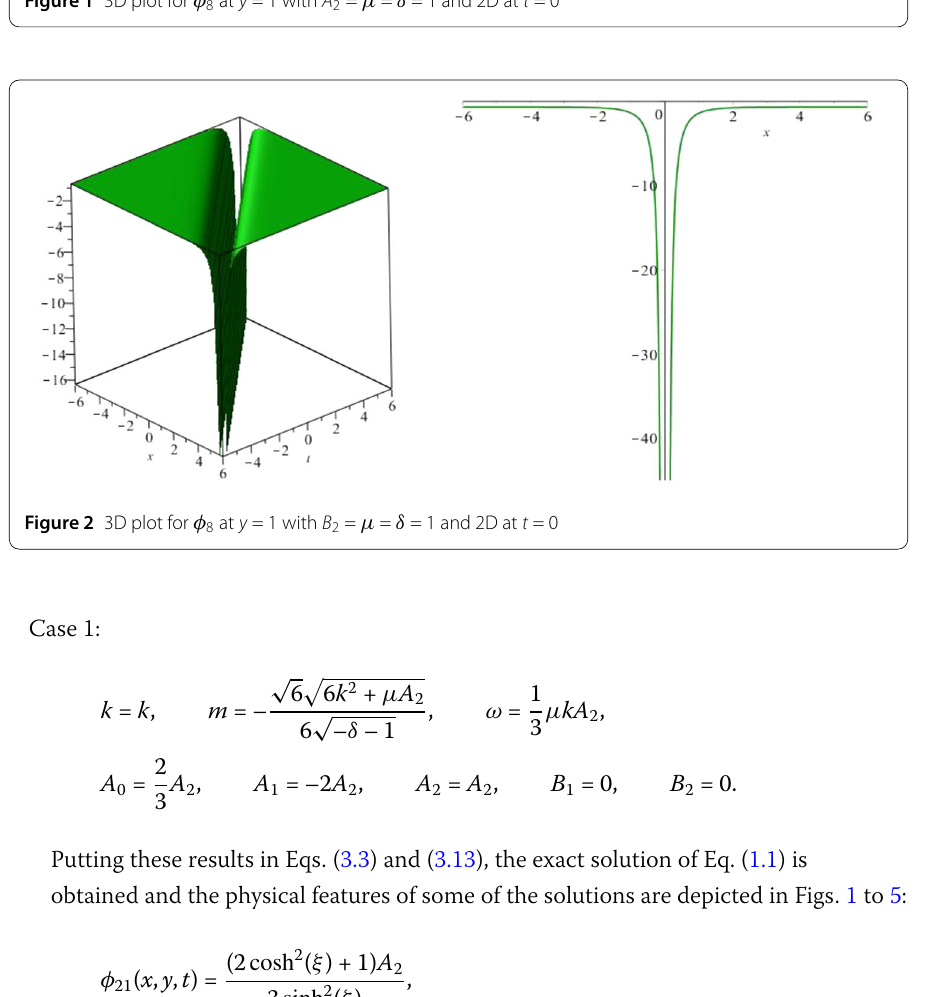
Figure 1 3D plot for φ 8 at y = 1 with A 2 = μ = δ = 1 and 2D at t = 0